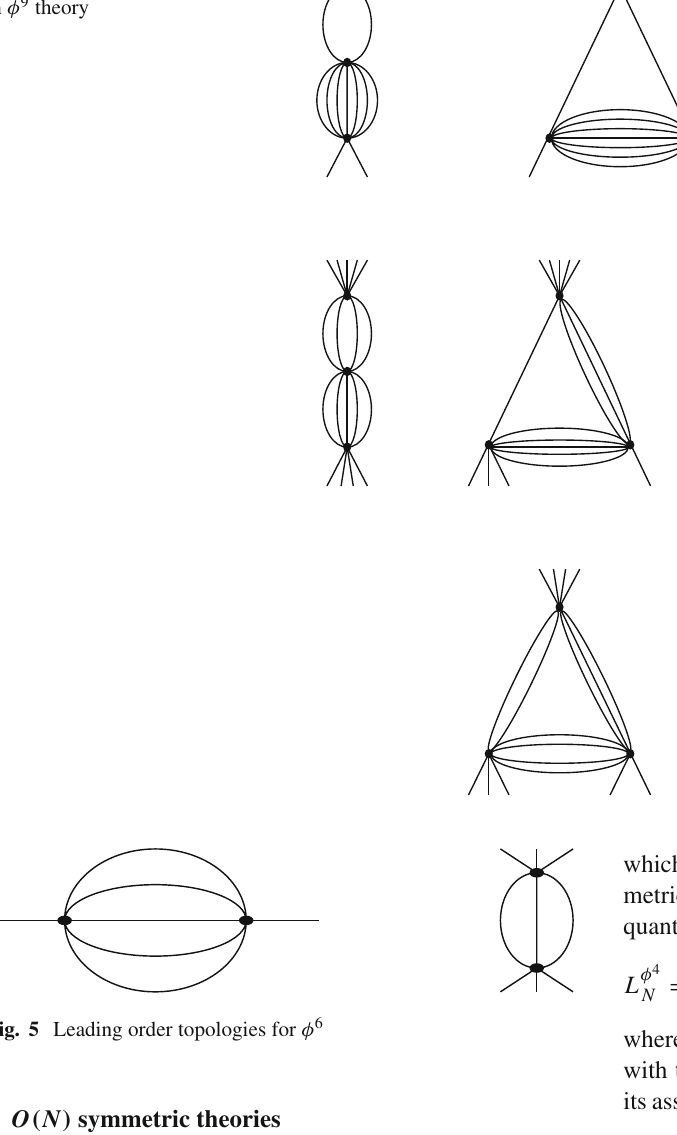
Fig. 4 Next to leading order topologies for 9-point function